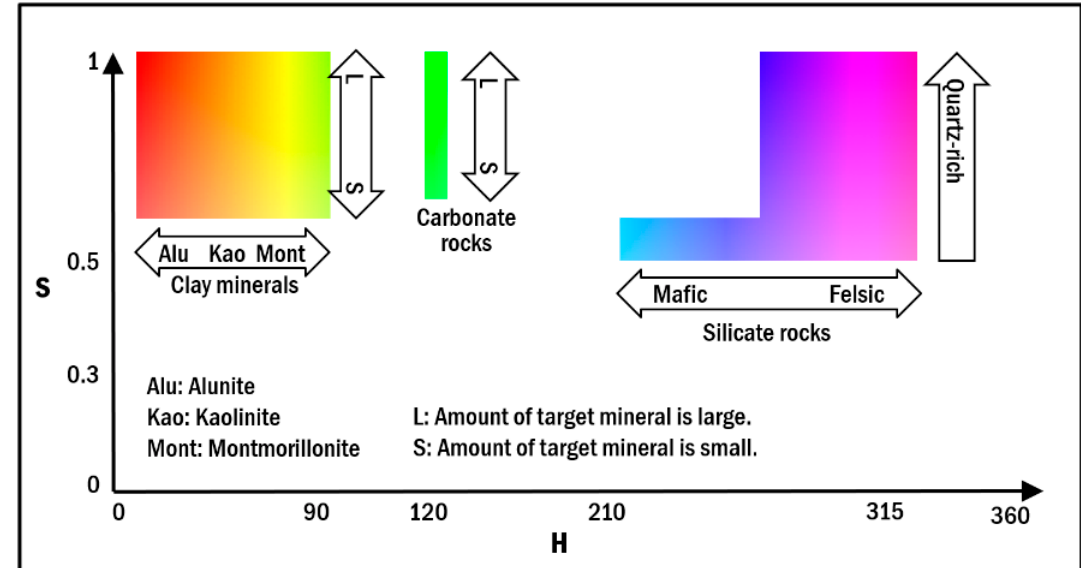
Figure 3. Meanings of the colors determined by the procedures to allocate lithological indices to the hue (H) and saturation (S) elements of the hue–saturation–value (HSV) color model. Silica-rich materials (e.g., quartzose sand and obsidian) are thus represented by H values close to 315, corresponding to pink, whereas silica-poor materials (e.g., basalt) are represented by H values close to 210, corresponding to blue. In this case, the S element was set to (0.5 + α ), where α , which ranges from 0.0 to 0.5, was determined from the value of the T-angle, which represents the mineral form of the silicates, whether the target felsic rock is composed of crystalline quartz or amorphous silica. T-angles ranging from 210.0 to 310.0 were linearly rescaled to the given range of α values. This assignment means that the parts of the images in which the T-angle was between 210.0 and 310.0 are represented by a more vivid color for high T-angles, whereas other areas are displayed in a dull color.